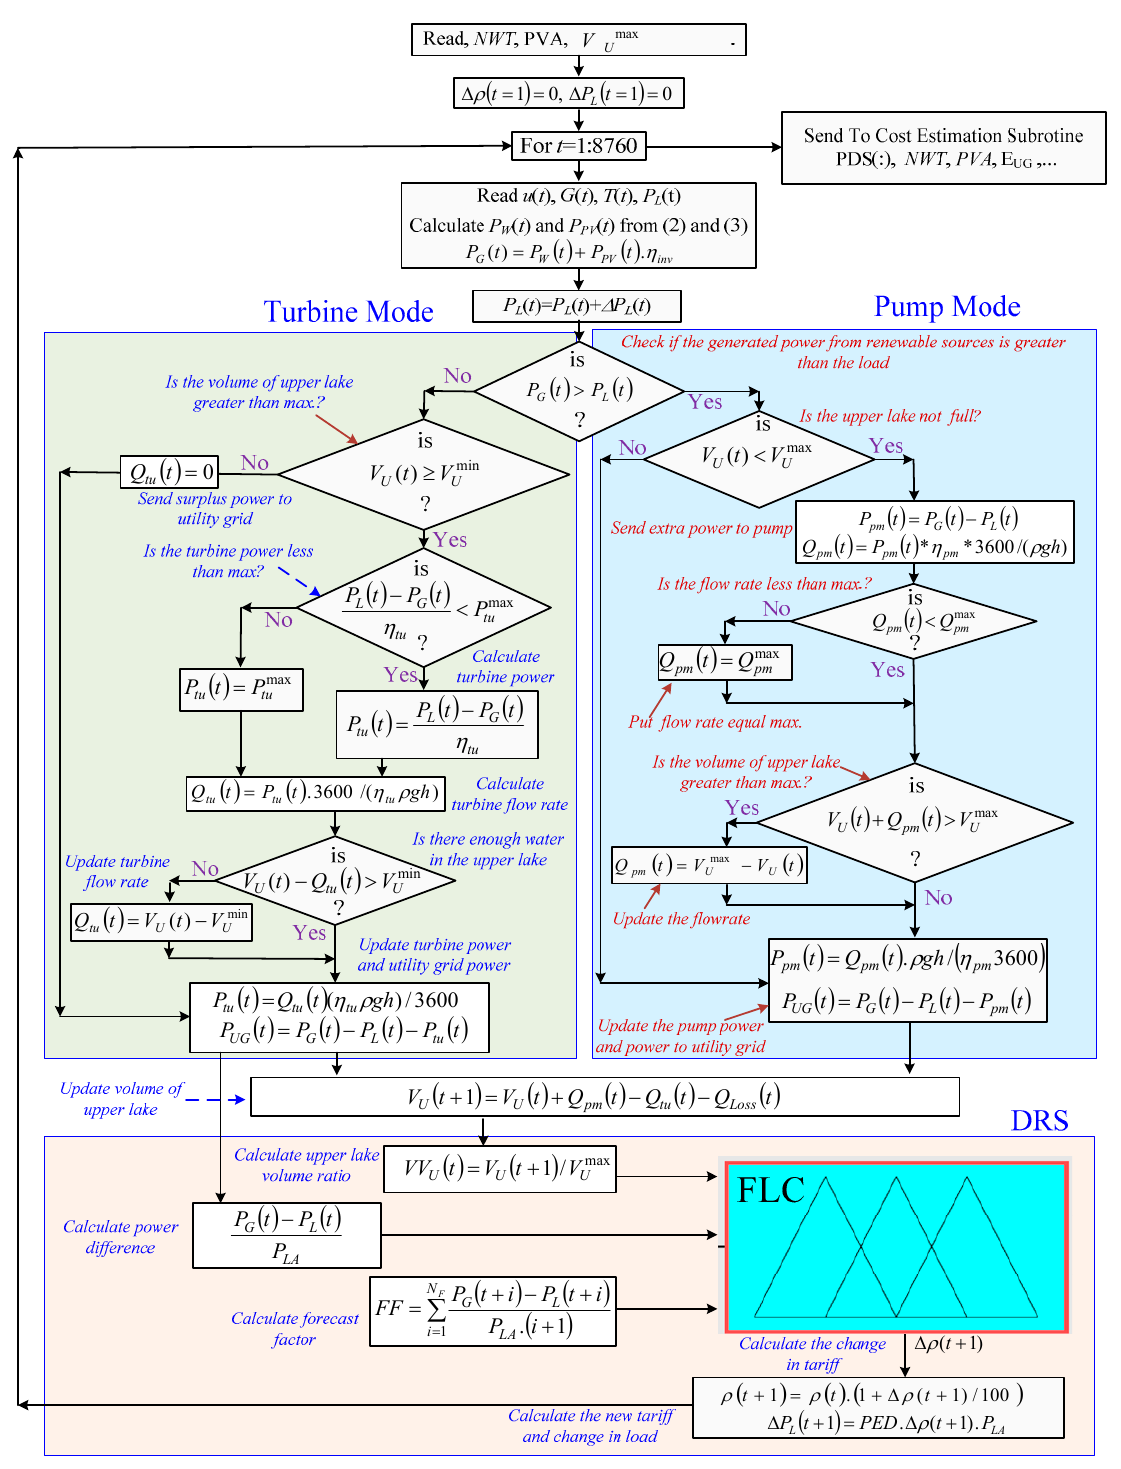
Figure 8. The dispatch strategy of using PHES as an ESS of the HRES.